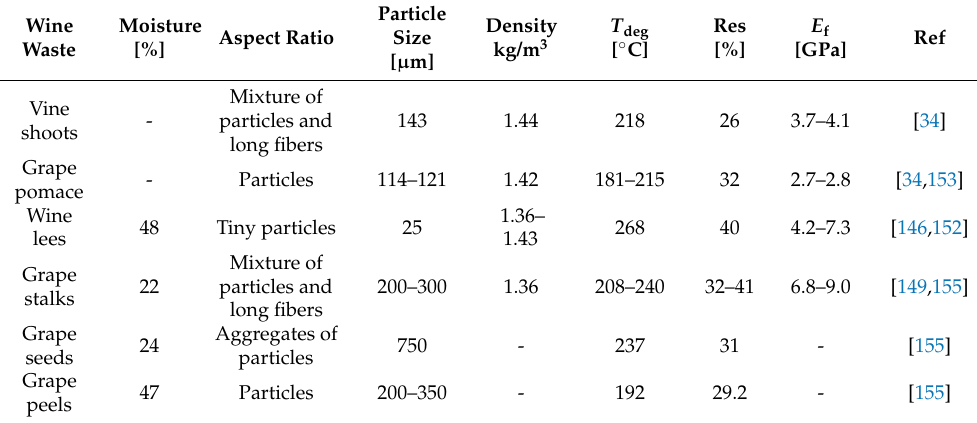
Table 7. Physical and thermogravimetric analysis (TGA) data of the wine by-products present in the